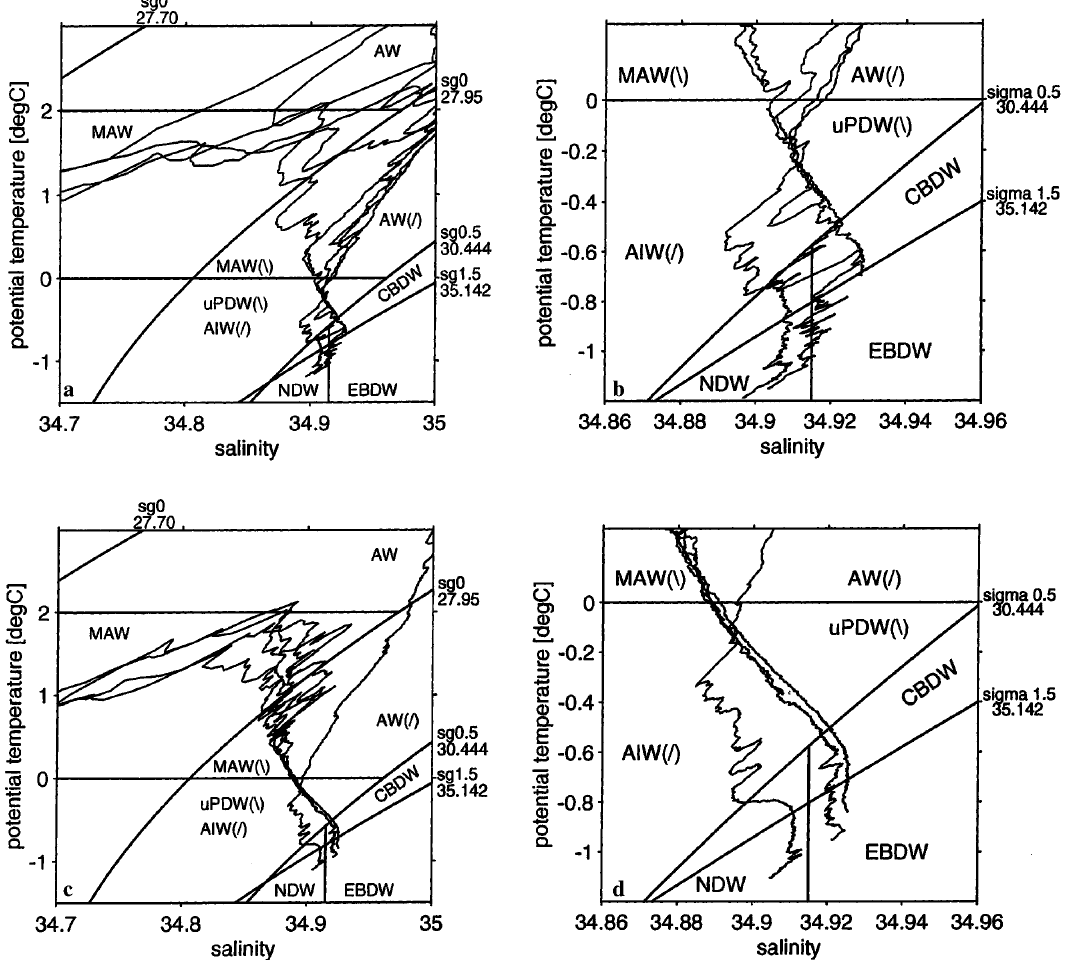
Fig. 17a–d. First row , Q -S diagrams for the 1984 Lance stations L249/84, L250/84, L251/84, L252/84 and L253/84, a full scale, b blow- up. Second row , Q -S diagrams for the 1997 Lance stations L2/97,